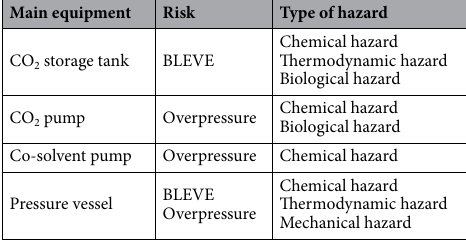
Table 9. Risk for each of the main equipment in SFE of G.